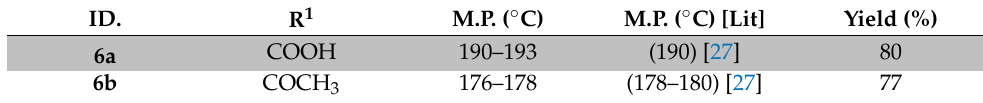
Table 2. M.Ps and yield % of Substituted phenyl azide, 6(a–c) .